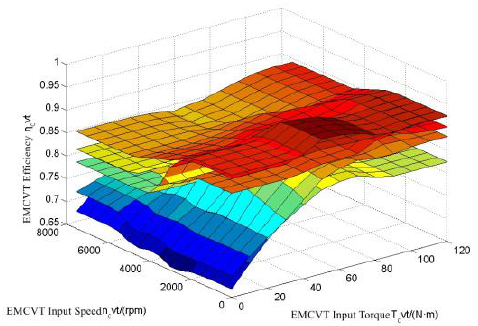
Figure 4. The electric-mechanical continuously variable transmission (EMCVT) efficiency model.